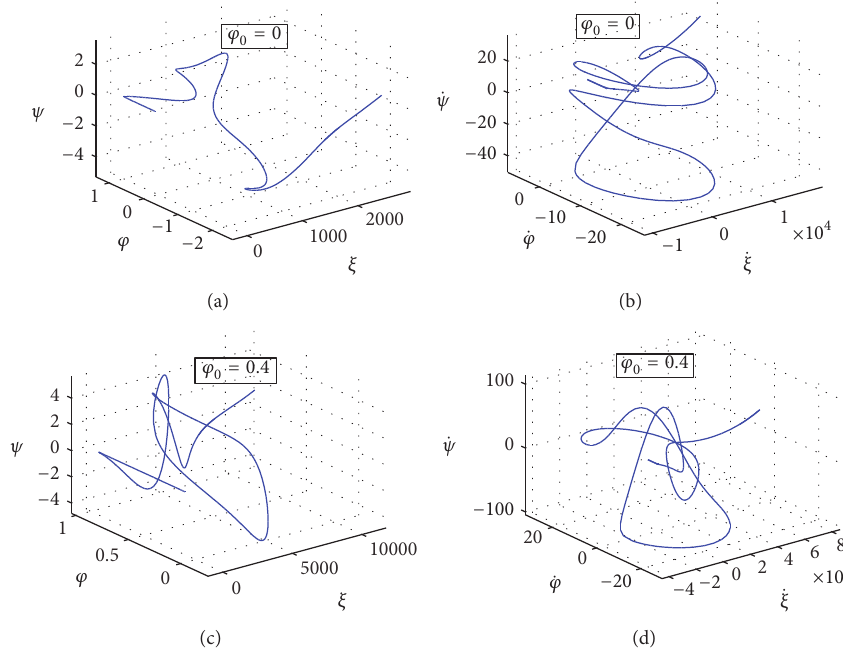
Figure 5: The 3D diagrams when 𝑏 = 3 m, ℎ = 4.5 , and 𝑎 = 0.5 m: (a, c) elucidate the variation of 𝜉 and 𝜑 versus 𝜓 when 𝜑 0 = 0 and = 0.4 rad, respectively, and (b, d) elucidate the variation of ̇𝜉 and ̇𝜑 versus ̇ 𝜓 when 𝜑 𝜑 0